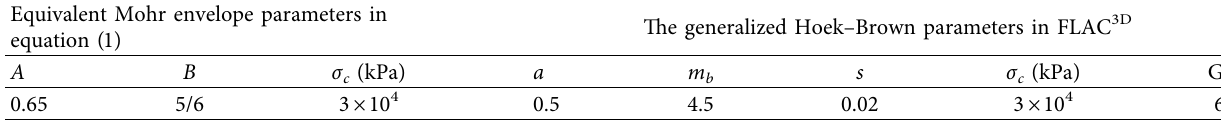
Table 5: Parameters of Hoek–Brown failure